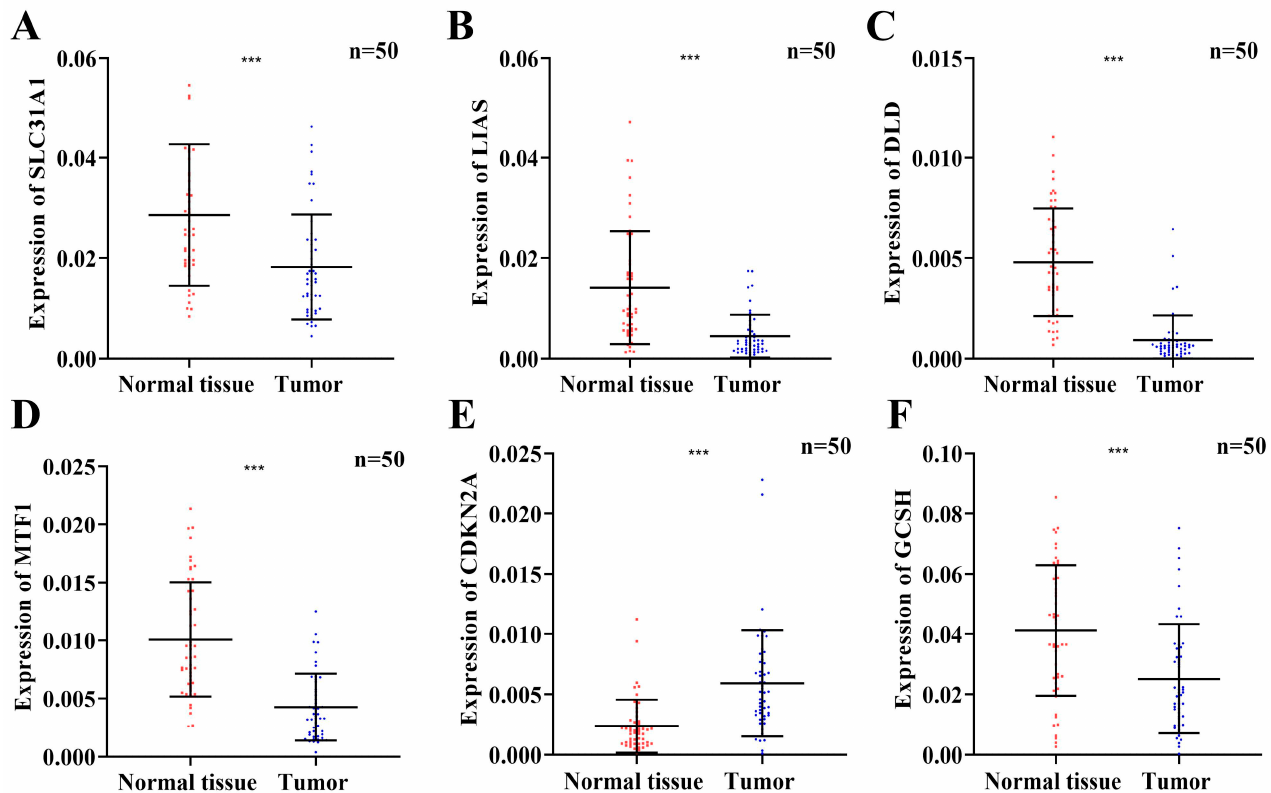
Figure 8. The relative expression levels of SLC31A1 ( A ), LIAS ( B ), DLD ( C ), MTF1 ( D ), CDKN2A ( E ), and GCSH ( F ) in 50 pairs of tissue samples from PTC patients by qRT-PCR. (*** p < 0.001) .